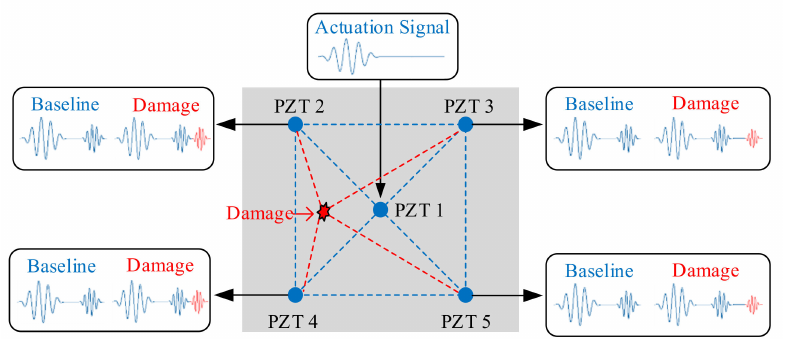
Figure 3. Schematic diagram of damage